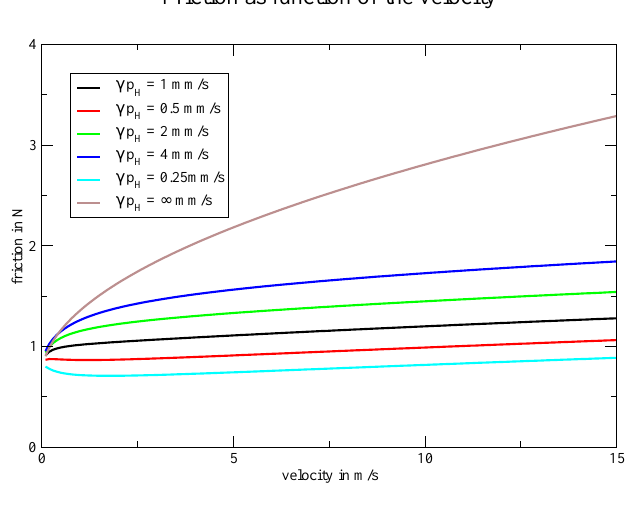
Figure 6: The total friction as function of the velocity for some values of